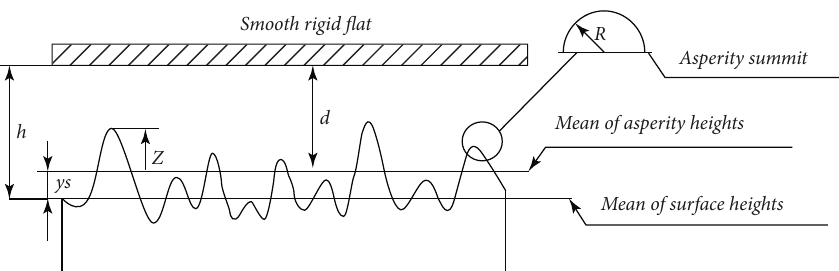
Figure 1: Schematic diagram of contact between a rough surface and a smooth rigid